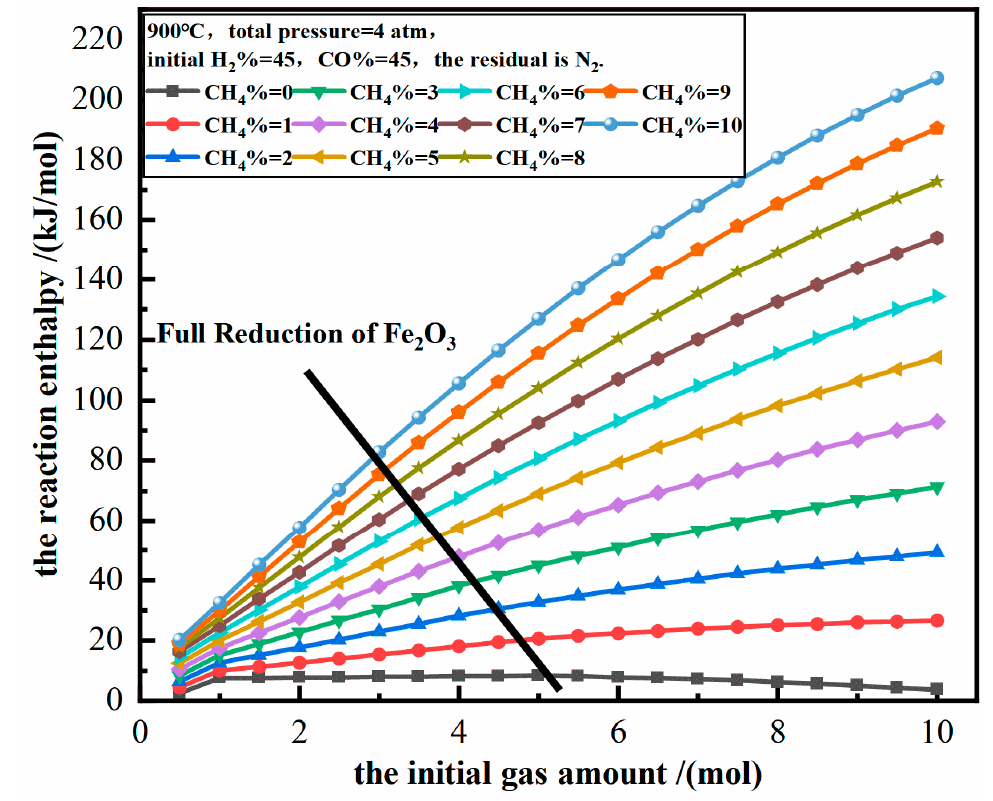
Figure 8. The relationship between the reaction enthalpy and the initial gas amount at 900 °C under 4 atm with H 2 % = 45, CO% = 45, CH 4 % = 0–10.